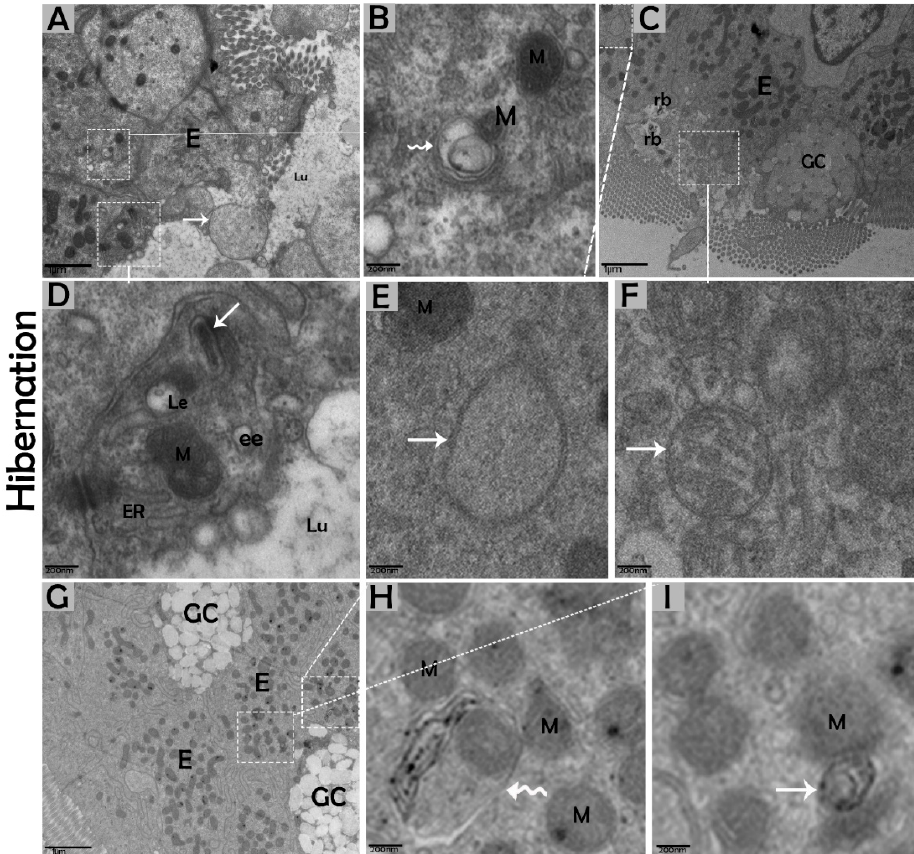
Figure 8. Luminal formation of autophagosomes and mitophagy in enterocytes of the small intestine in P. sinensis during hibernation ( A – I ). E, enterocyte; GC, goblet cell; M, mitochondria; ER, endoplasmic reticulum; rb, residual bodies; autophagosome (white arrow); mitophagy (curve white arrow); ee, early endosome; Le, late endosome; Lu, lumen. Scale bar = 1 µm ( A , C , G ) and 200 nm ( B , D , E – I ). Table 3. The comparison of subcellular autophagy appearances in enterocytes of the small intestine of P. sinensis during hibernation and nonhibernation. Enterocyte Hibernation Nonhibernation Phagophore